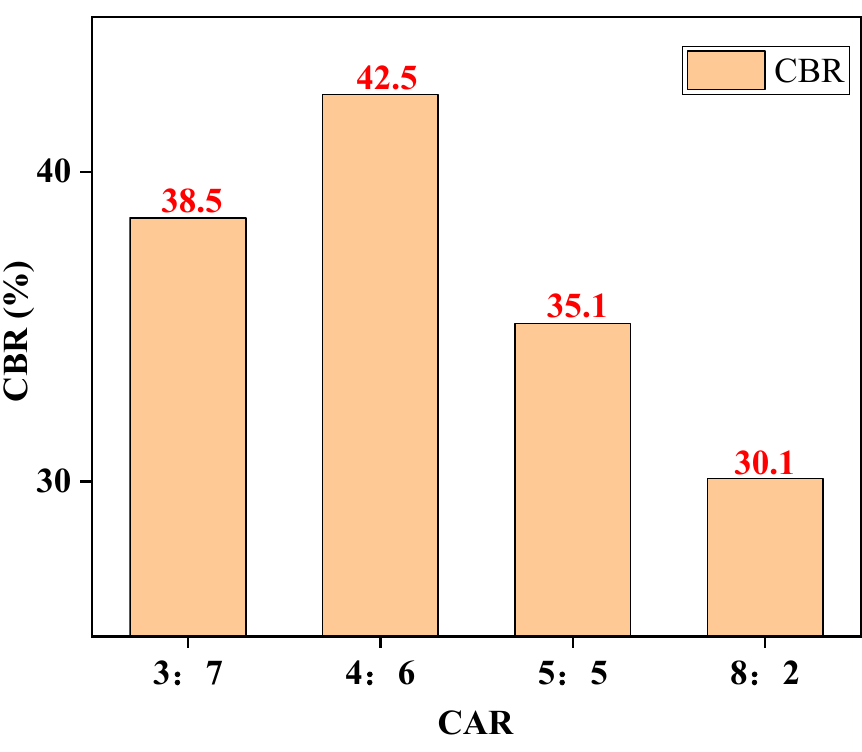
Figure 6. CBR values for different CARs.